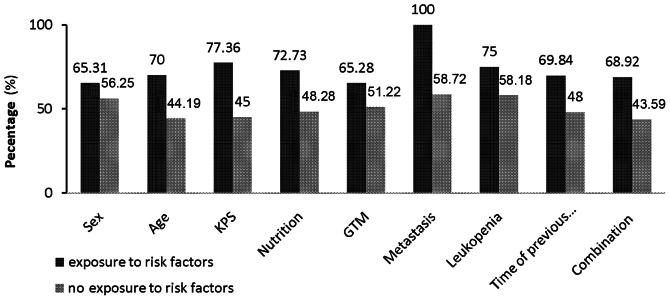
Correlation between potential risk factors and the probability of grade III/IV neutropenia. KPS, Karnofsky Performance Status; GTM, tumor staging.